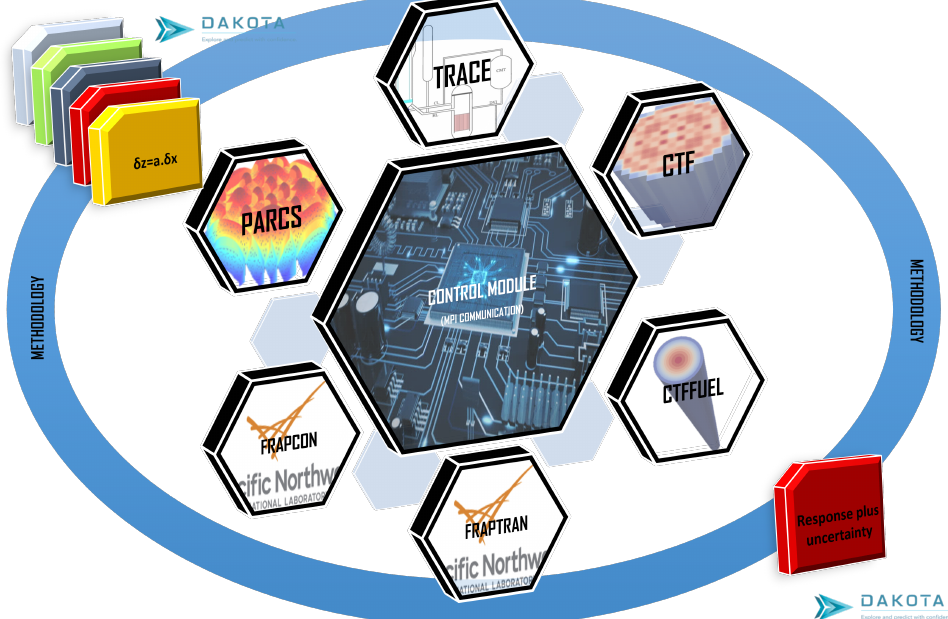
Figure 3. General scheme of the MPI driven multi-physics multi-scale general simulation framework developed at